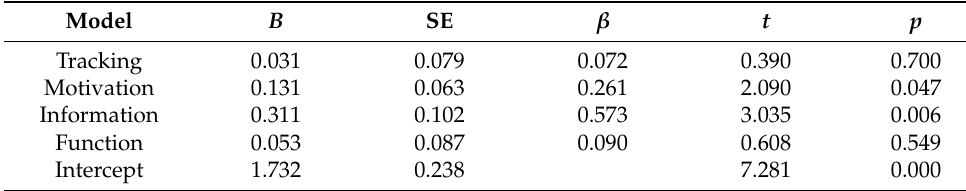
Table 3. Regression analyses: association between app content (tracking, motivation, information, and function) and MARS scores.